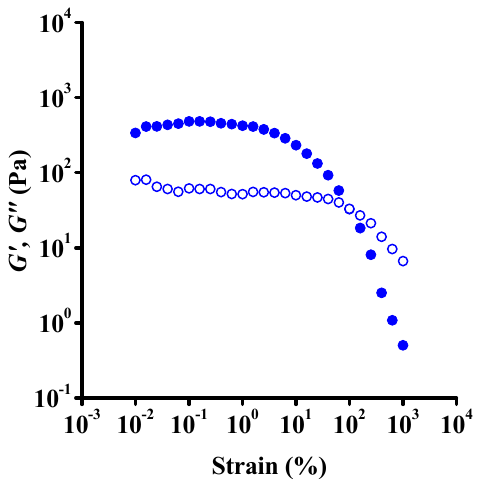
Figure 4. Strain-dependent oscillatory shear measurements on a fresh suspension at constant angular frequency 1 rad · s − 1 . Solid and open symbols represent storage ( G (cid:48) ) and loss ( G ”) moduli, respectively. Results of the parallel measurements and the low-torque limit of moduli are shown in Figure S4.